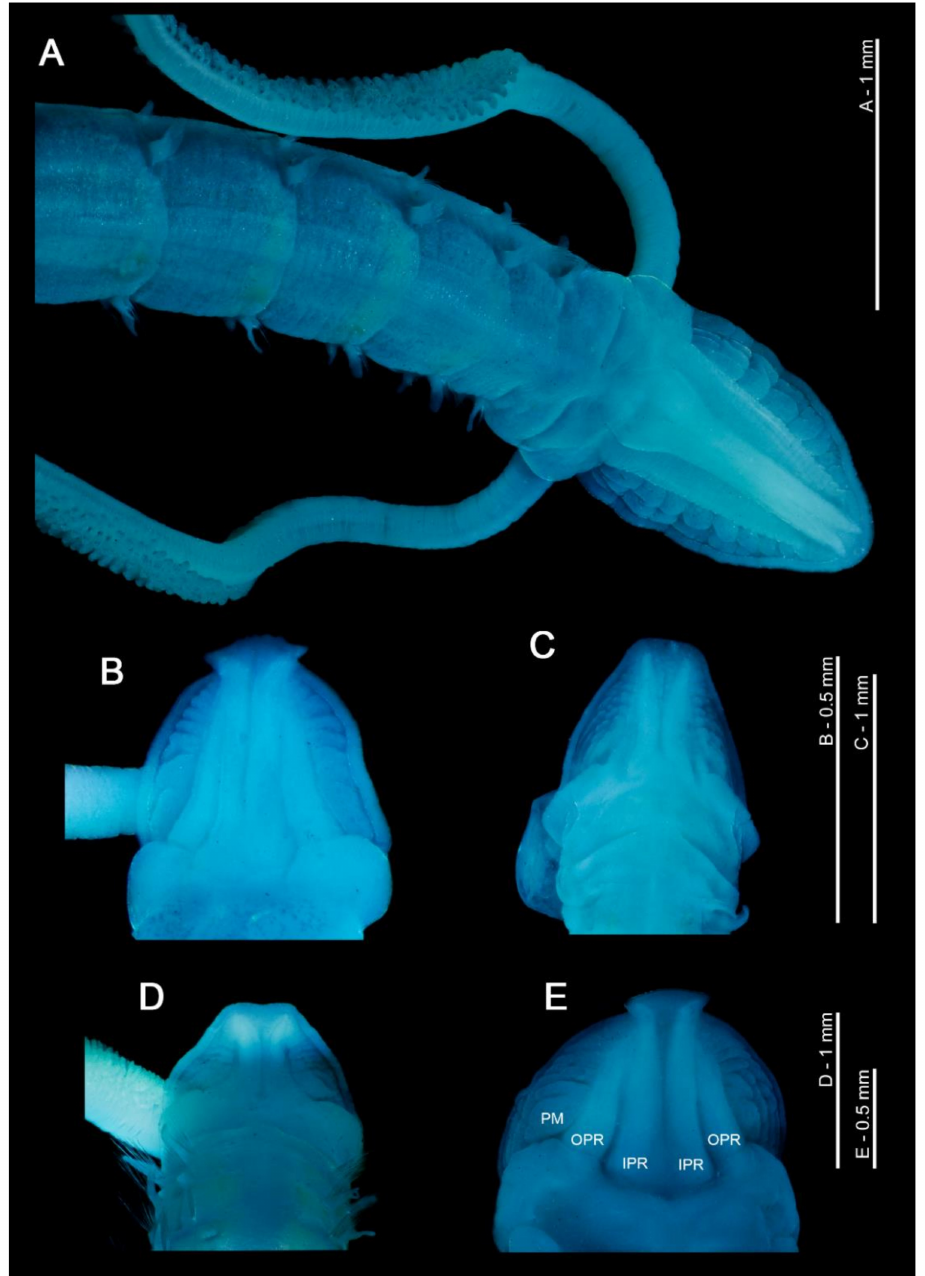
Figure 1. ( A ) Anterior end of Magelona mirabilis , showing prostomium, palps, achaetous first segment and first five chaetigers (dorsal view); ( B – E ) magelonid prostomia (dorsal views) of M. crenulifrons, M. mahensis, M. symmetrica and M. wilsoni respectively. All stained with methyl green. Abbreviations: IPR—inner prostomial ridge, OPR—outer prostomial ridge, PM—prostomial